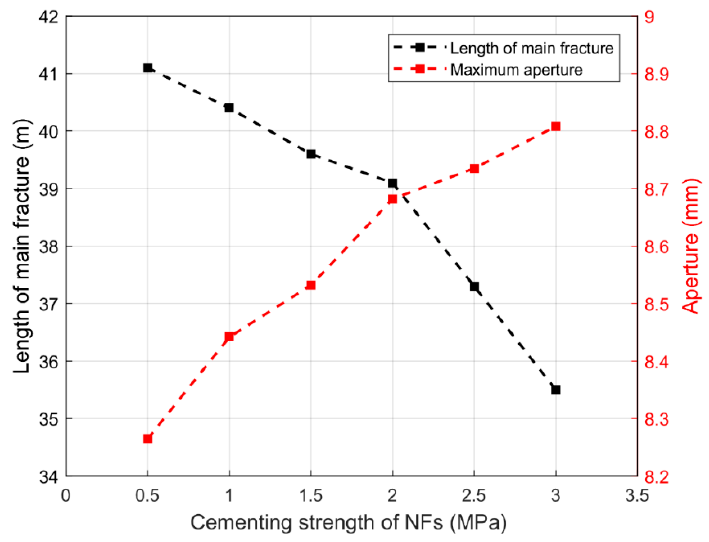
Figure 18. Fracture length under different tensile strengths of rock.